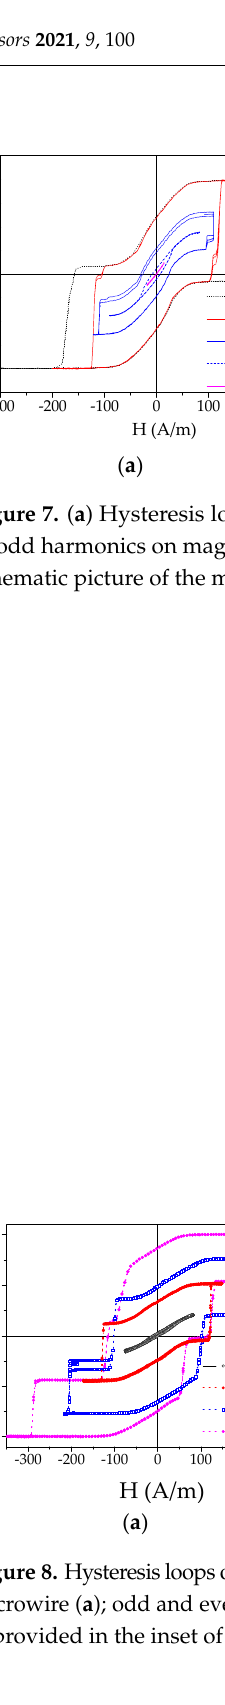
A/m (which corresponds to H